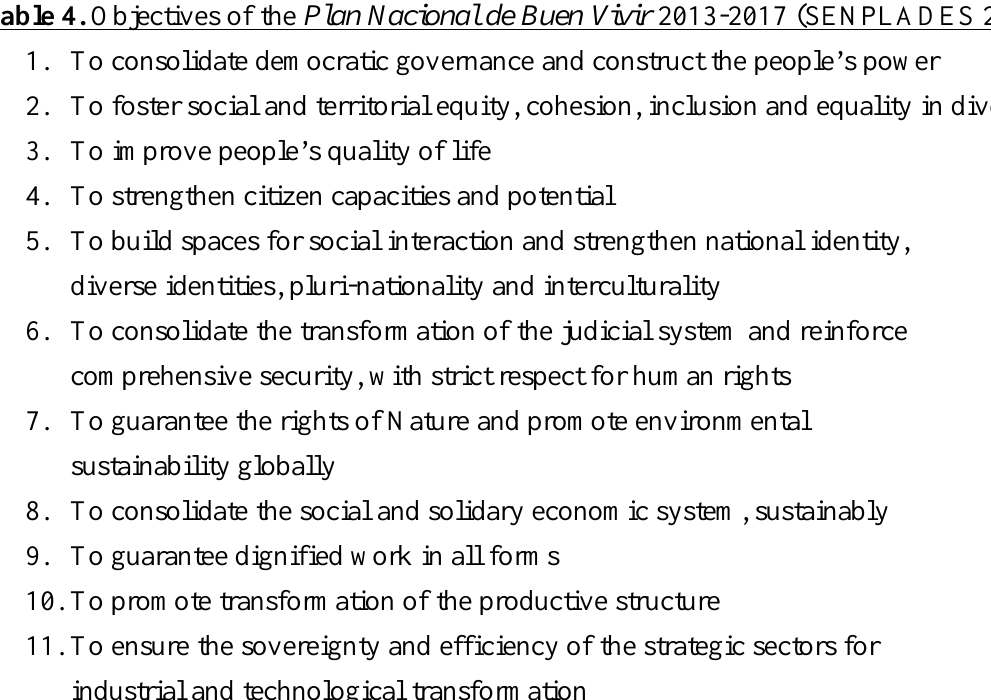
Table 4. Objectives of the Plan Nacional de Buen Vivir 2013-2017 (SENPLADES